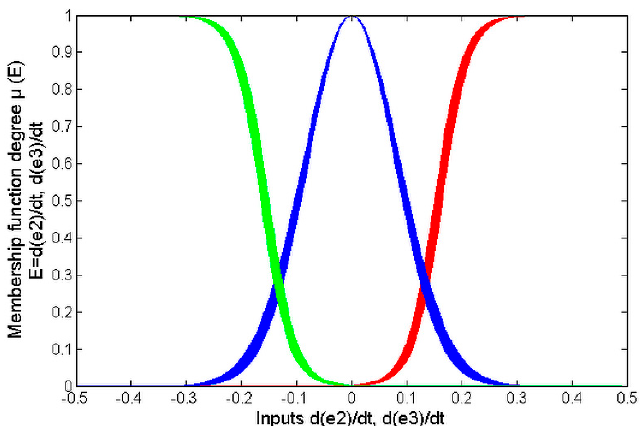
Figure 6. Membership functions used by the inputs